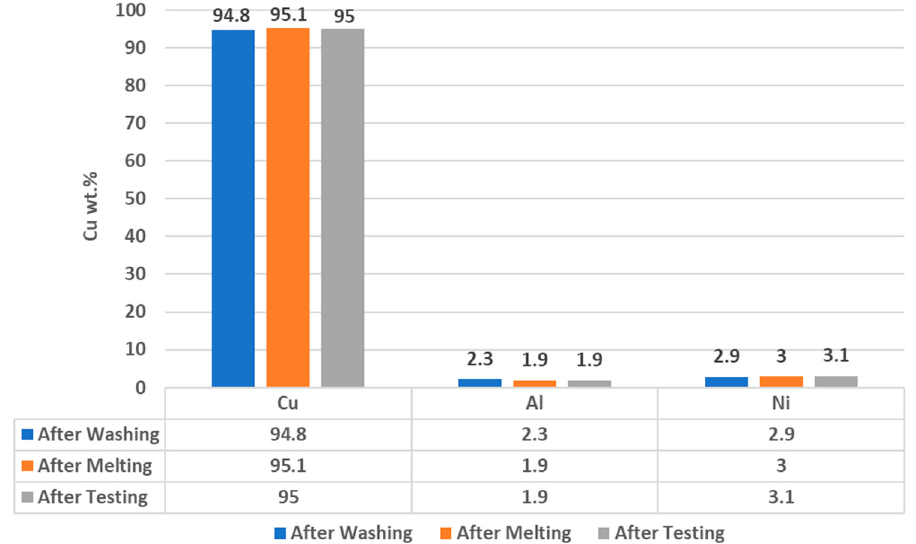
Figure 8. Elemental mapping for ( a ) As-received Al CC from used batteries, ( b ) Al CC from recycled